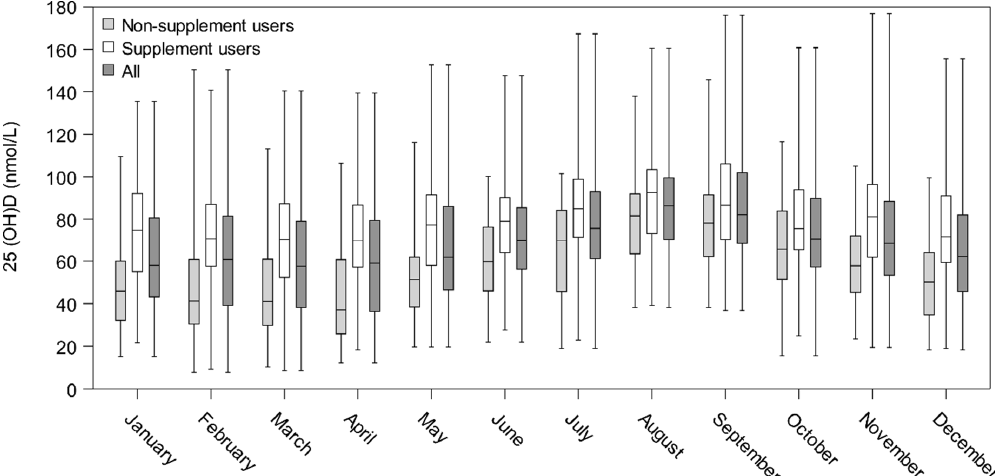
Figure 2. Box plot (box from Q1 to Q3) showing 25(OH)D (nmol/L) concentrations among all monthly participants ( n = 167) and non-supplement users ( n = 77). Tails show min and max values, while the line, –, indicates the median.